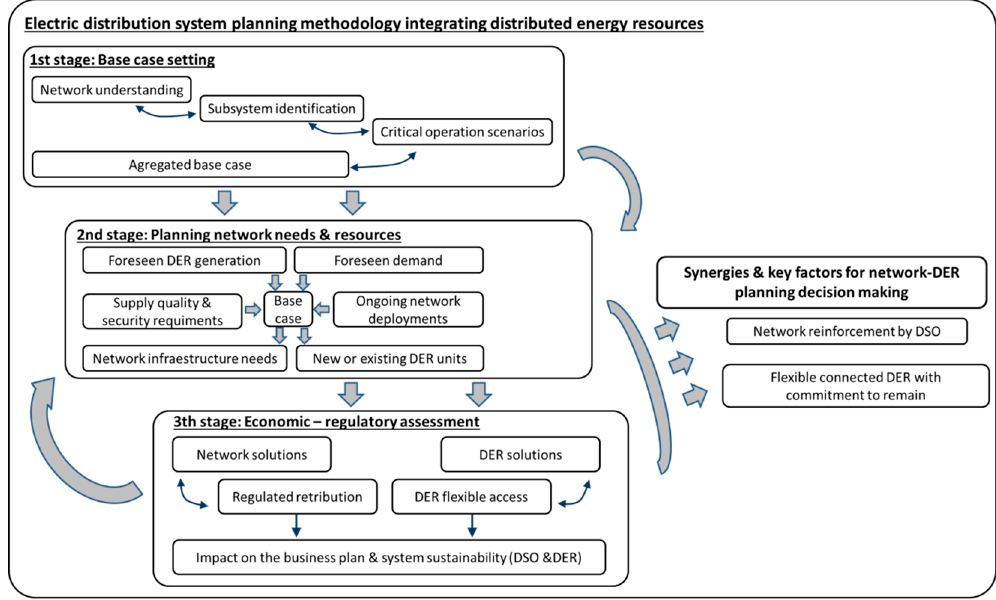
Figure 2. Diagram of the proposed electric distribution system analysis and planning methodology, integrating distributed energy resources.